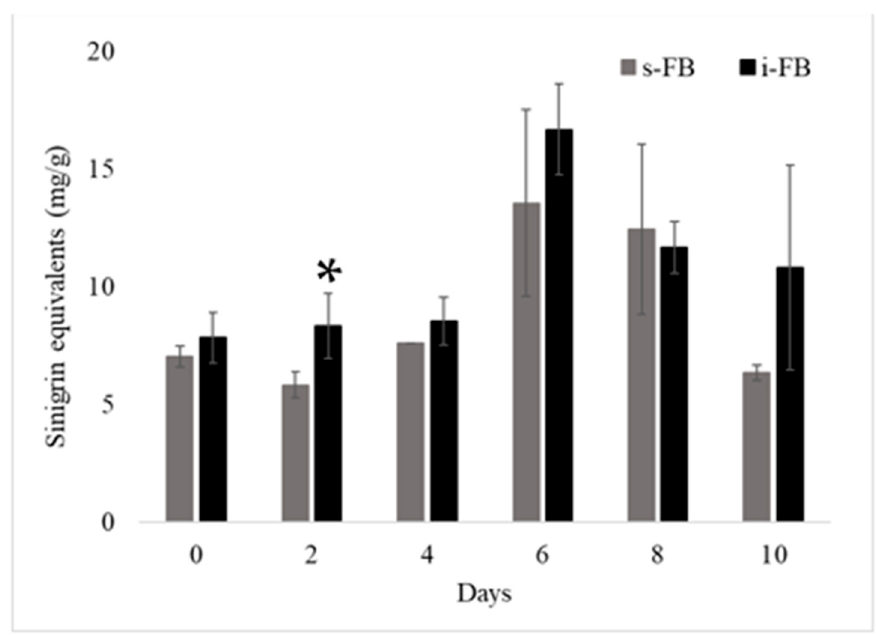
Figure 3. Quantification of sinigrin in fermented broccoli. s-FB: spontaneous fermentation; i-FB: induced fermentation (co-culture) *: significant difference ( p < 0.05).